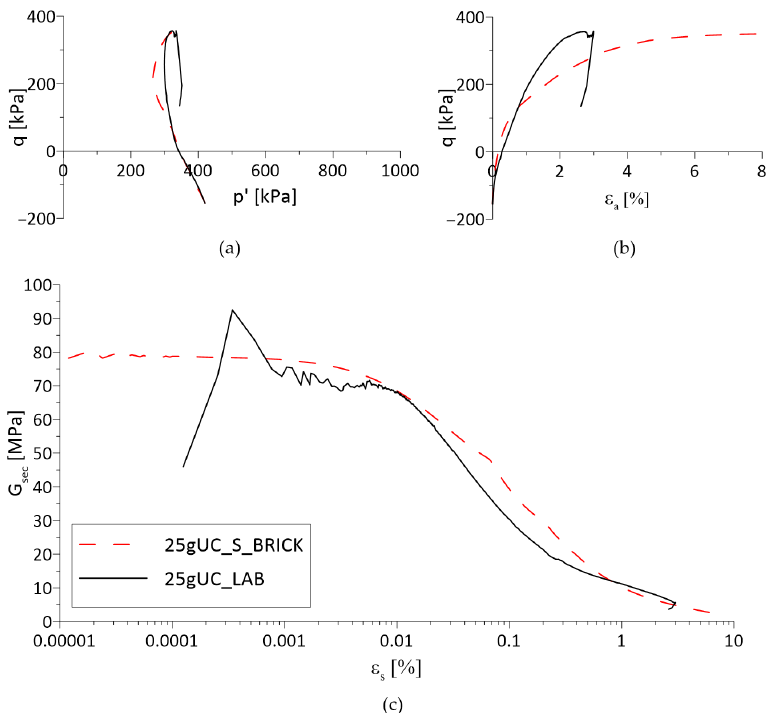
Figure 10. Validation of the SA_BRICK model against laboratory sample 25gUC [47]: ( a ) q – p (cid:48) diagram; ( b ) q– ε a diagram; ( c ) G sec – ε s